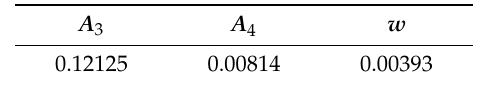
Table 9. Identification results of parameters of standard variation (STD) of the damage variable STD d ( ε ) .